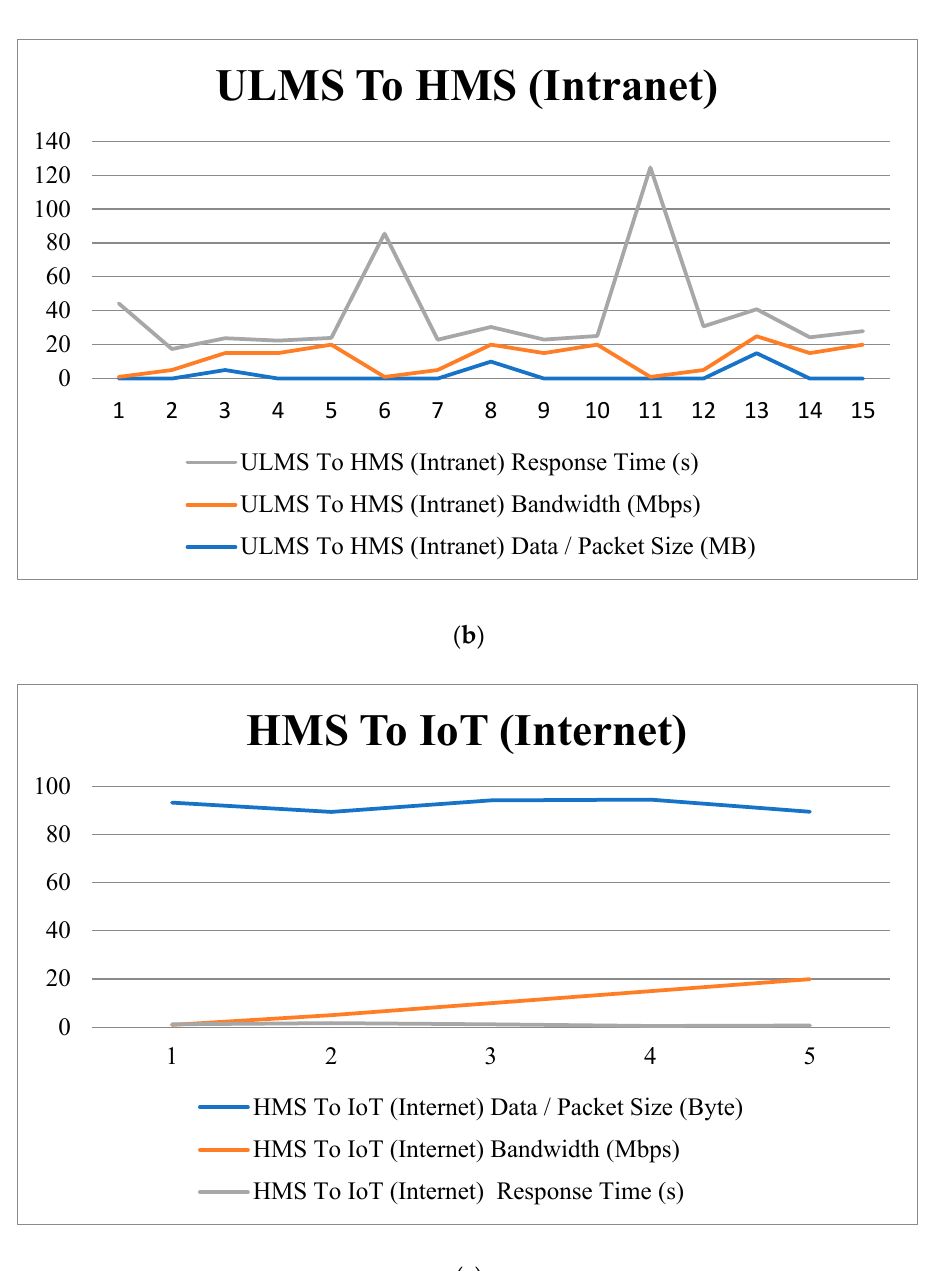
Figure 13. Line chart diagram based on the response time ( a – c ). Table 5. HMS To IoT (Internet) .